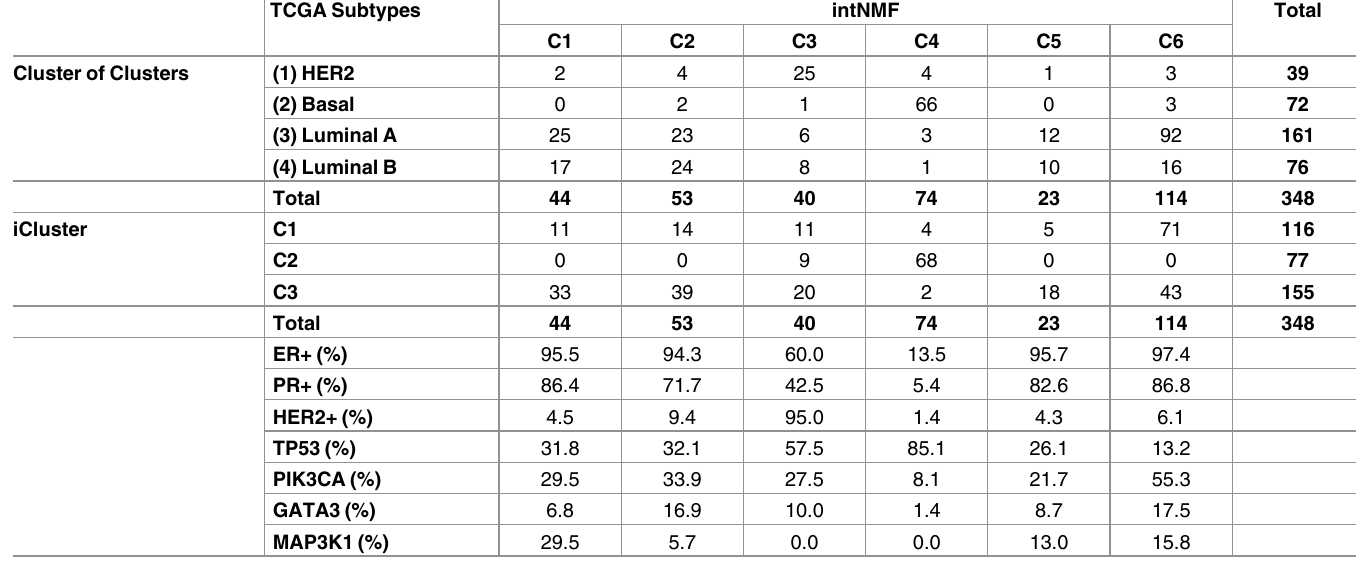
Table 1. Cross tabulation of intNMF subtypes with TCGA subtypes and iCluster subtypes using multiplatform Breastcancer data. The summary table, followedby cross tabulation tables, represents the receptorstatus for estrogen (ER), progesterone (PR) and humanepidermalgrowth factor 2 (HER2) presented as percentage of their presence in each of the six intNMF clusters; and somatic mutations in four genes TP53 , PIK3CA , GATA3 and MAP3K1